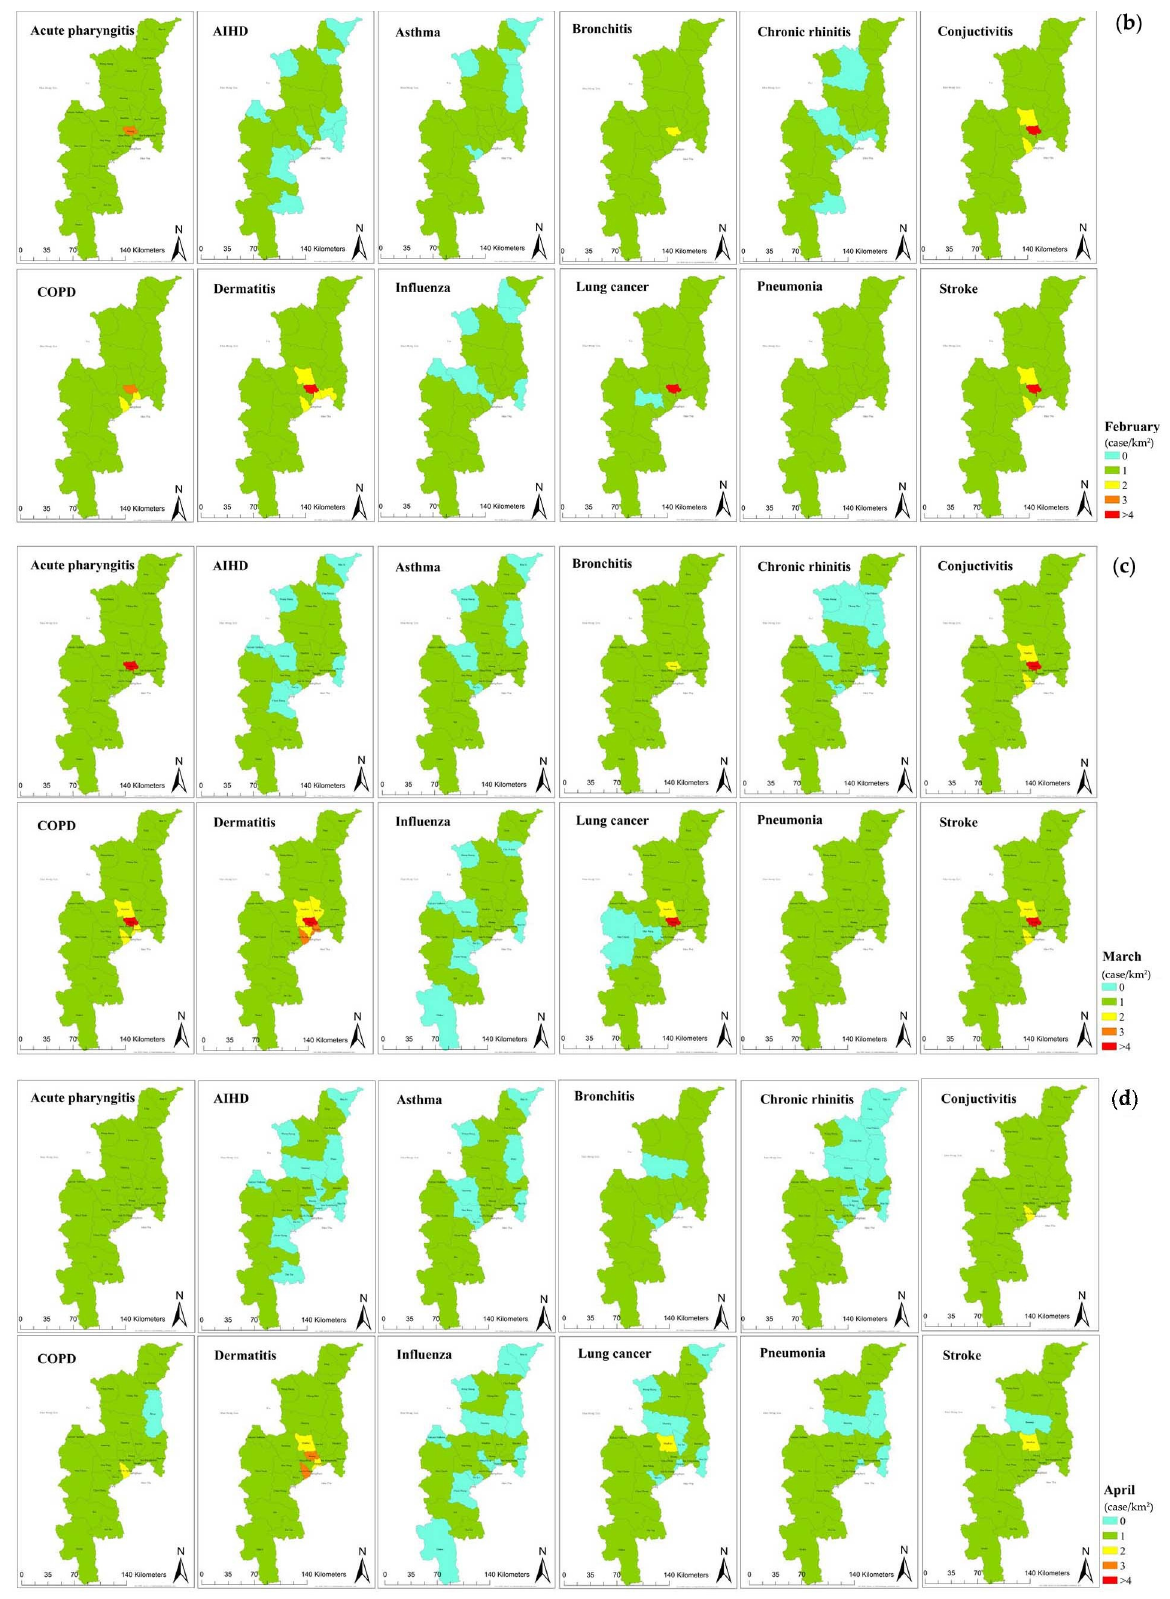
Figure 3. The spatial distribution of health risk map in all-cause morbidity in Chiang Mai from January to April 2021 ( a ) in January, ( b ) in February, ( c ) in March, and ( d ) in April.